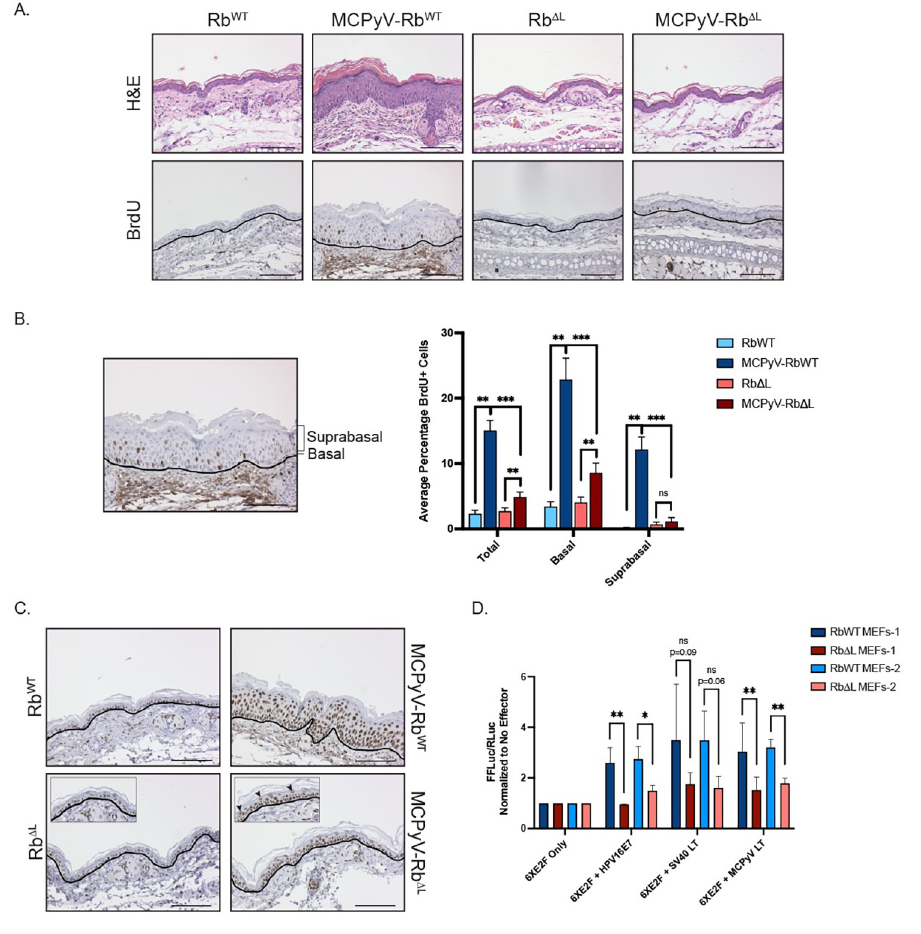
Fig 3. MCPyV T antigen-induced cellular proliferation and E2F-dependent gene expression are significantly reduced, but not eliminated, in the skin of MCPyV-Rb Δ L mice. A) Ear tissues harvested from Rb WT , MCPyV-Rb WT Rb Δ L , and MCPyV-Rb Δ L mice were analyzed using immunohistochemistry for BrdU and counterstained with hematoxylin (bottom). BrdU-positive cells contain brown nuclei. The black line indicates the basement membrane between the epithelium and the underlying dermis. Corresponding representative H&E-stained images are included as a reference (top). All scale bars = 100 μ m. B) For BrdU quantitation, basal cells were defined as any cell in contact with the basement membrane. Suprabasal cells included all other cells within the stratified epithelium that were not touching the basement membrane. An image is shown with brackets identifying the suprabasal layer and a line pointing to the basal layer. The number of total, basal, and suprabasal BrdU-positive cells in the stratified epithelium were counted in 10 fields of view per slide from each mouse per group. These values were then divided by the total number of epithelial cells in each sample to calculate the percentage of BrdU-positive cells, and these values were then averaged. An average of the averages was then calculated for each group of mice. Error bars indicate standard deviation. A Wilcoxon Rank Sum test was used to compare values among groups. Asterisks indicate statistical significance ( �� p � 0.002, ��� p � 0.0007) and “ns” means non-significant. Please refer to the text for more information regarding statistical comparisons. C) Ear tissues harvested from Rb WT , MCPyV-Rb WT , Rb Δ L , and MCPyV-Rb Δ L mice were analyzed using immunohistochemistry for the MCM7 protein and counterstained with hematoxylin (bottom). MCM7-positive cells contain brown nuclei. The black line indicates the basement membrane between the epithelium and the underlying dermis. Insets are enlarged images to highlight suprabasal cells staining positive for MCM7 (black arrowheads). All scale bars = 100 μ m. D) E2F-luciferase assay results from primary mouse embryonic fibroblasts (MEFs) isolated from pRb WT and pRb Δ L mice transfected with viral protein effectors. MEFs from litter-matched pRb WT and pRb Δ L embryos from two different litters were used: RbWT MEFs-1 and Rb Δ L MEFs-1 (dark blue and maroon, respectively) and RbWT MEFs-2 and Rb Δ L MEFs-2 (light blue and pink, respectively). Cells were transfected with an E2F-luciferase reporter construct (6XE2F; Firefly luciferase) only, or co-transfected with 6XE2F reporter plus SV40 large T antigen (LT), the MCPyV LT, or human papillomavirus 16 (HPV16) E7 protein. In all conditions, cells were co-transfected with a control plasmid expressing Renilla luciferase that was used to normalize for transfection efficiency. At 48 hours post-transfection, a dual-luciferase assay was performed to quantify firefly and Renilla luciferase expression in each condition. Following normalization of all luciferase values (firefly/ Renilla ), the values in cells only transfected with the reporter (6XE2F Only) were set to 1.0 and all other values were compared to this value within